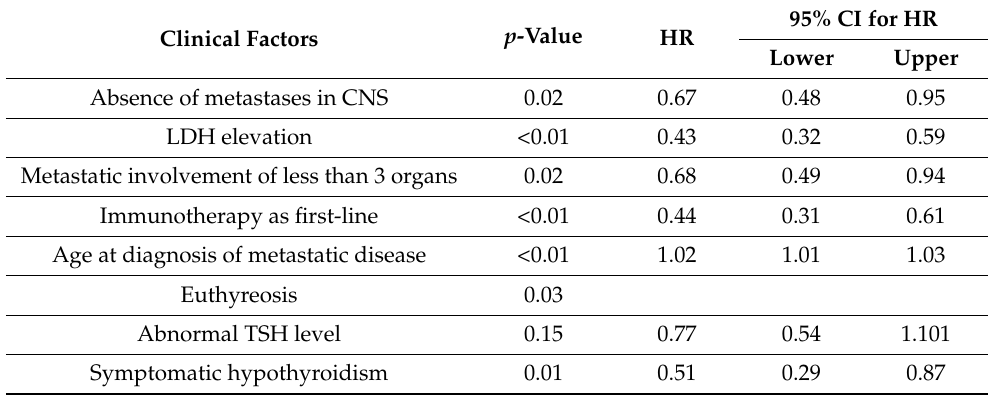
95% CI for HR Lower Upper